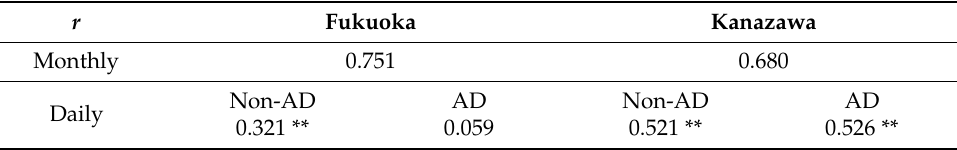
Table 2. Correlation coefficient ( r ) between total PAH and TSP in Fukuoka and Kanazawa in non-AD and AD